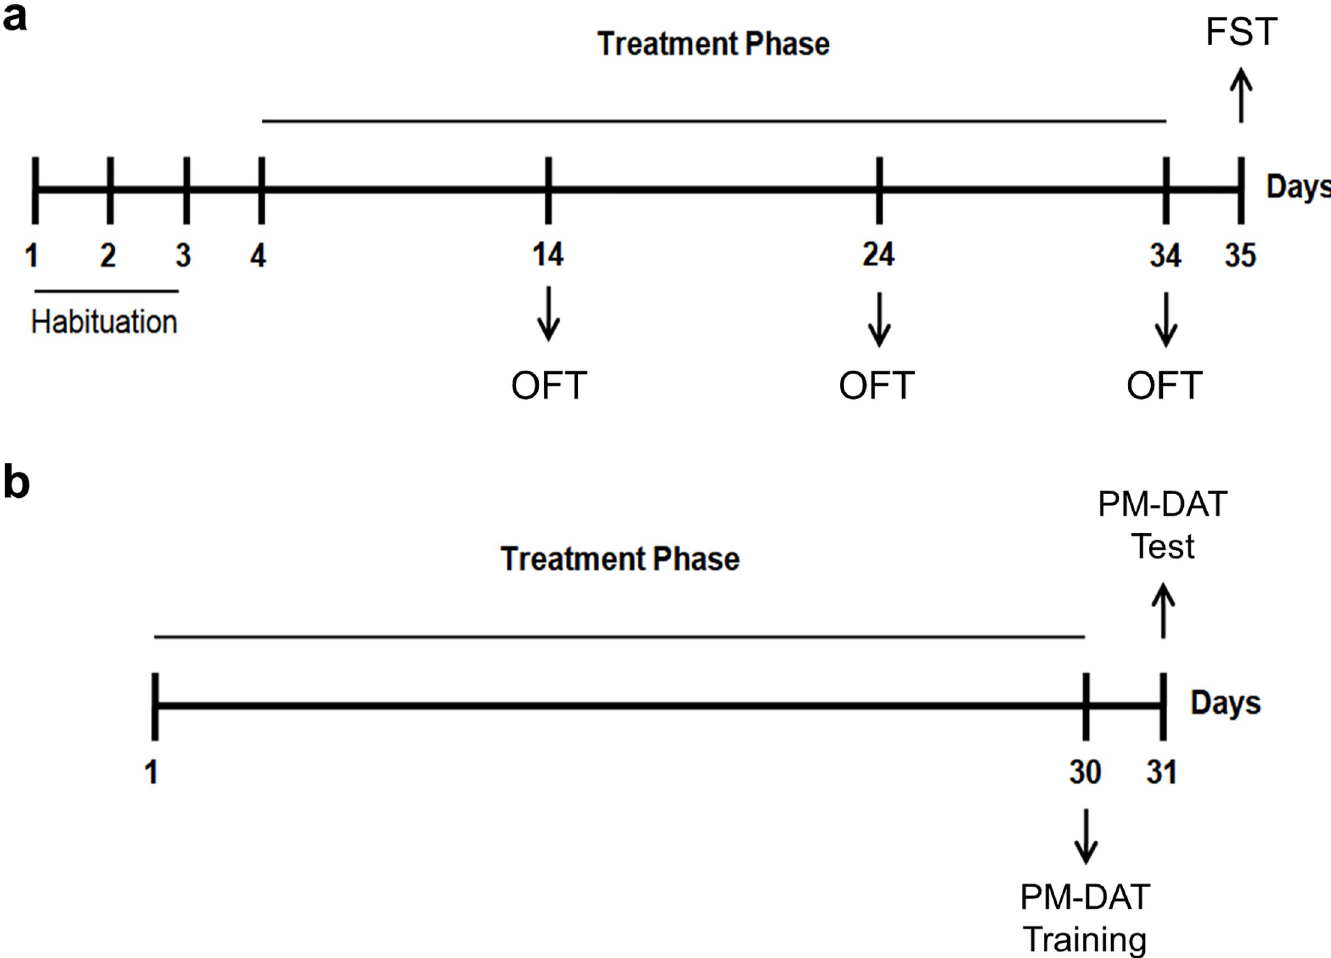
Fig 1. Protocol design across experimental days. On Experiment 1 (a), animals were submitted to 3 days of habituation to the open-field apparatus, and treated (oral gavage) with vehicle, Lactobacillus plantarum 286 (Lp 286, 10e9UFC/0.1 mL) or Lactobacillus plantarum 81 (Lp 81, 10e9 UFC/0.1 mL) solutions once/day for 30 days. Animals were submitted to the open-field test (OFT) on days 14, 24 and 34, and to the forced swim test (FST) on day 35. On Experiment 2, animals received once/daily administrations (oral gavage) of vehicle, Lp 286 or Lp 81 solutions and were submitted to the training and test sessions of the plus-maze discriminative avoidance test (PM-DAT) on days 30 and 31,